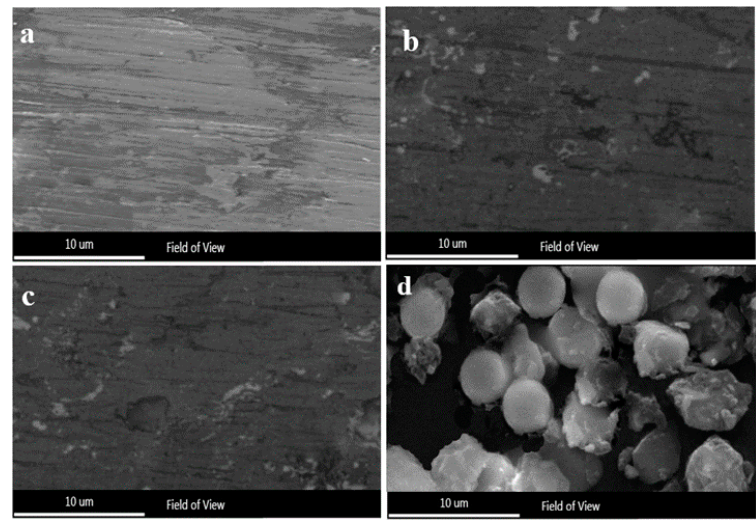
Figure 1. Optical micrograph of the ( a ) as-spray coating, ( b ) coating with heat 650 °C and ( c ) coating with heat 800 °C; ( d ) SEM image of Fe 49.7 Cr 18 Mn 1.9 Mo 7.4 W 1.6 B 15.2 C 3.8 Si 2.4 alloy powders.